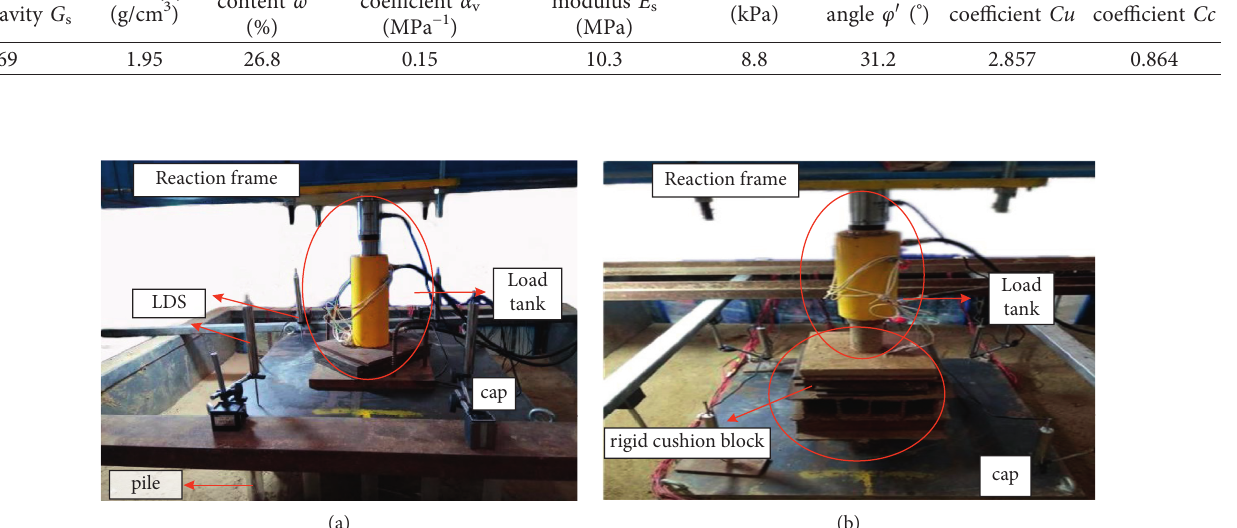
Figure 3: Installation process of the test models: (a) the photo of HCPF; (b) the photo of LCPF.